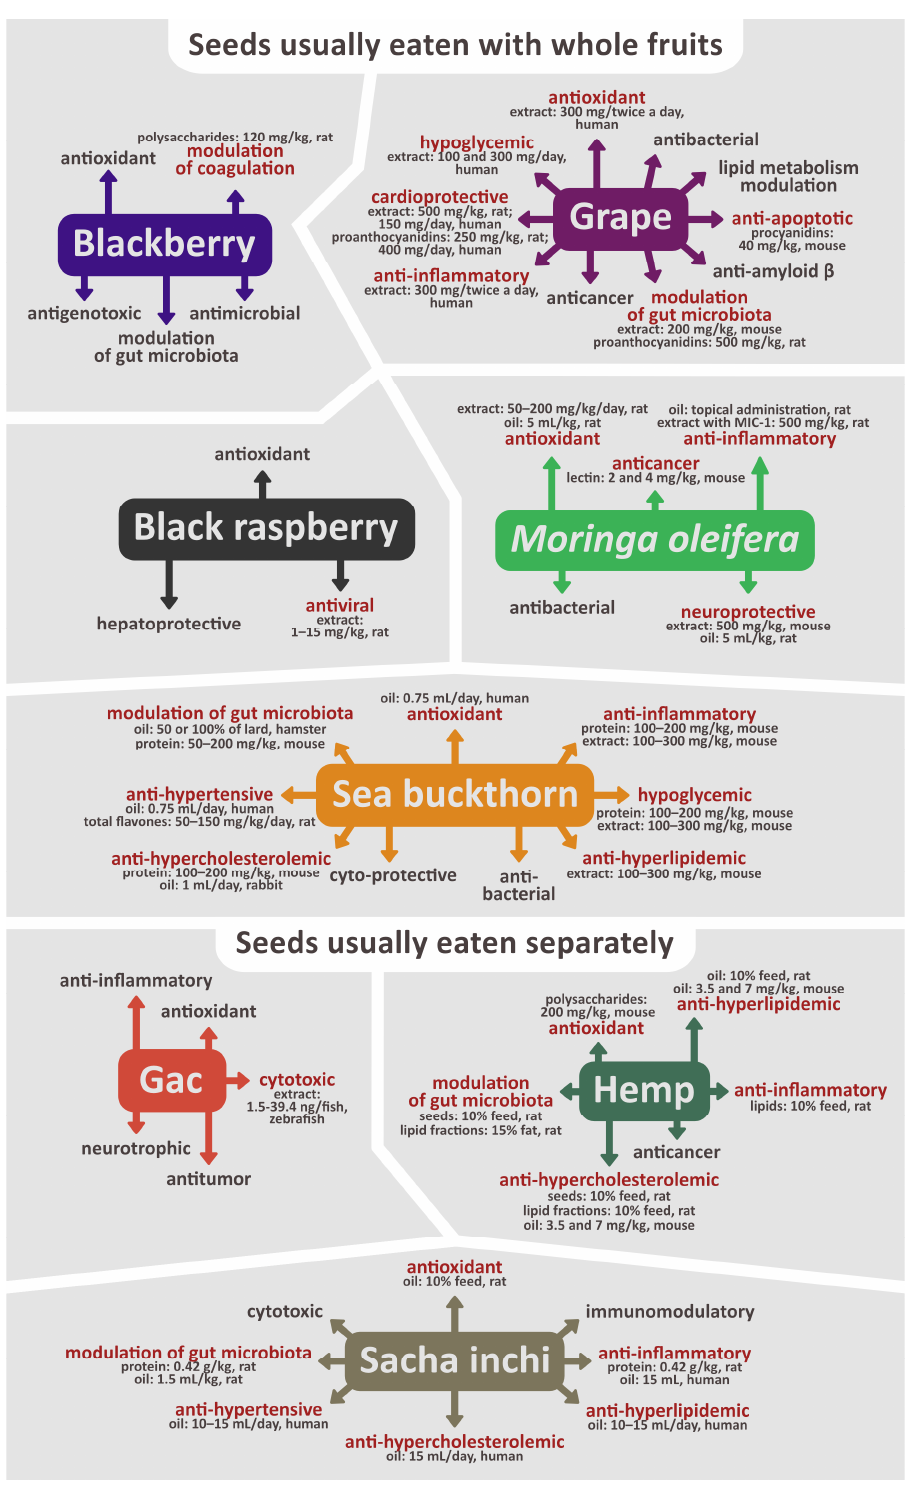
Figure 2. Biological activity of seed extracts, fractions, and oil. The activity of singular isolated compounds was not included, as it is presented in Table 1. The activities that were studied in vivo are marked with red font. The figure is a compilation of data from Sections 4 and 5. MIC-1, moringa isothiocyanate-1.